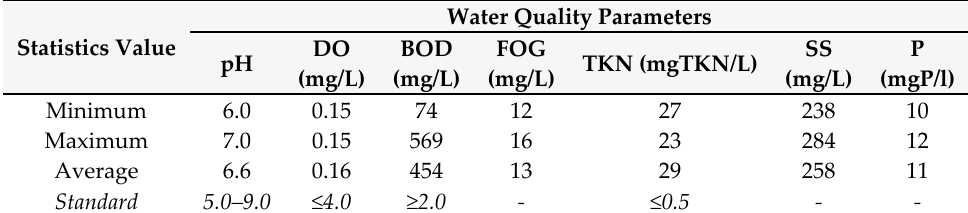
Table 2. Summary of statistical analysis results regarding the quality of